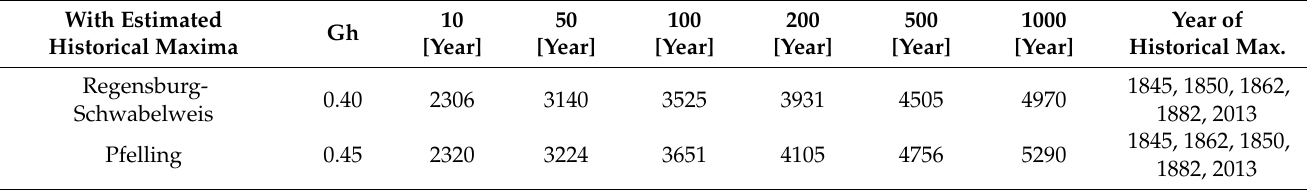
Table 3. Design values of selected T -year annual maximum discharges in [m 3 s − 1 ] along the Danube River (R: runoff depth, Gh: historical skew